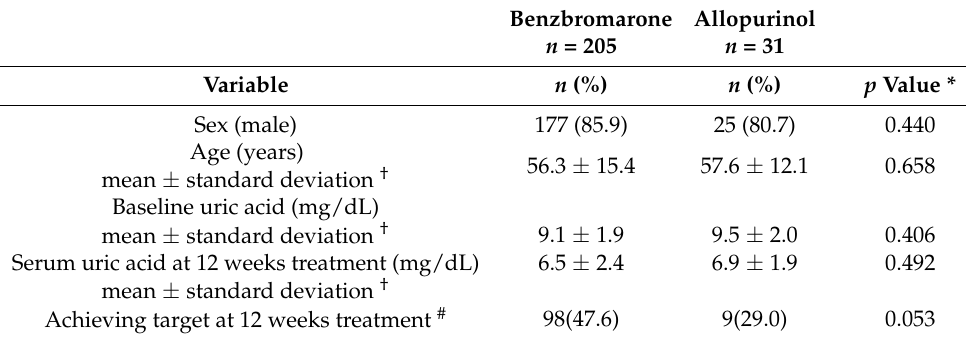
Table 4. The serum uric acid and the proportion of achieving treatment target between benzbro- marone users and allopurinol users at one local hospital in